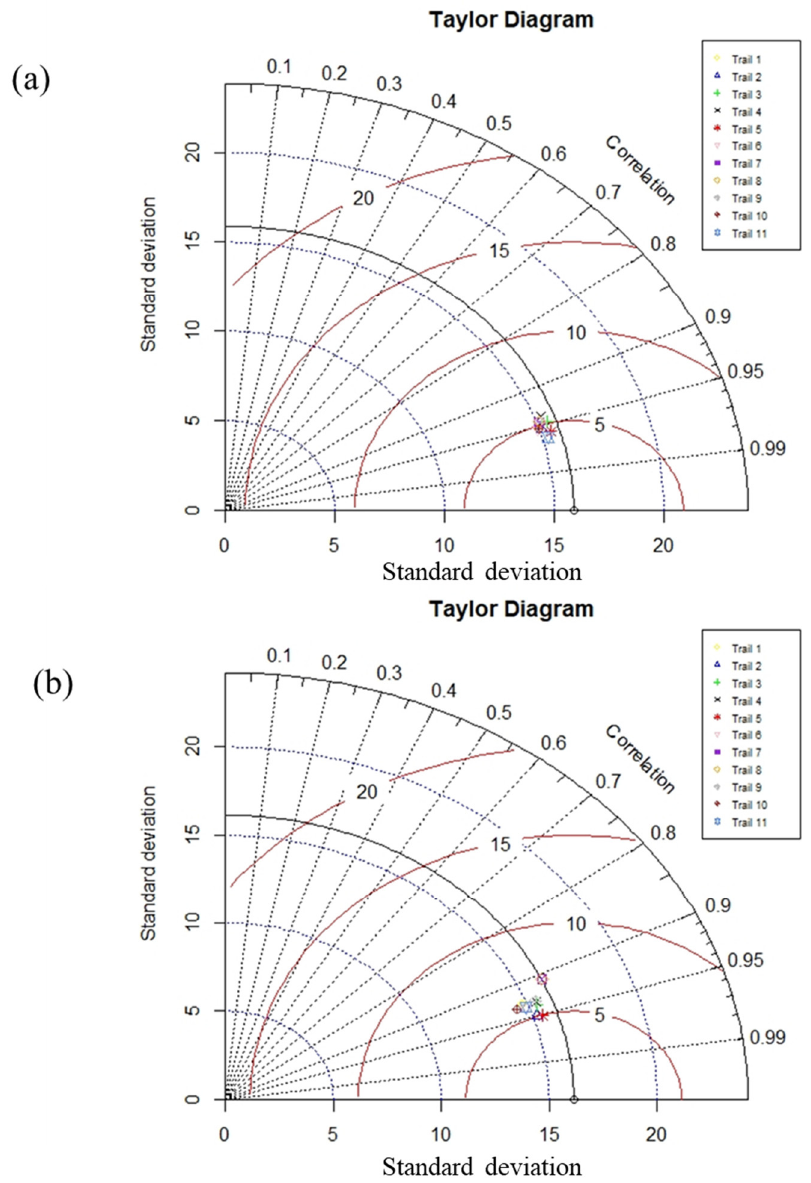
Figure 5. Comparison of the trials using Taylor diagram for ( a ) training data and ( b ) validation data.